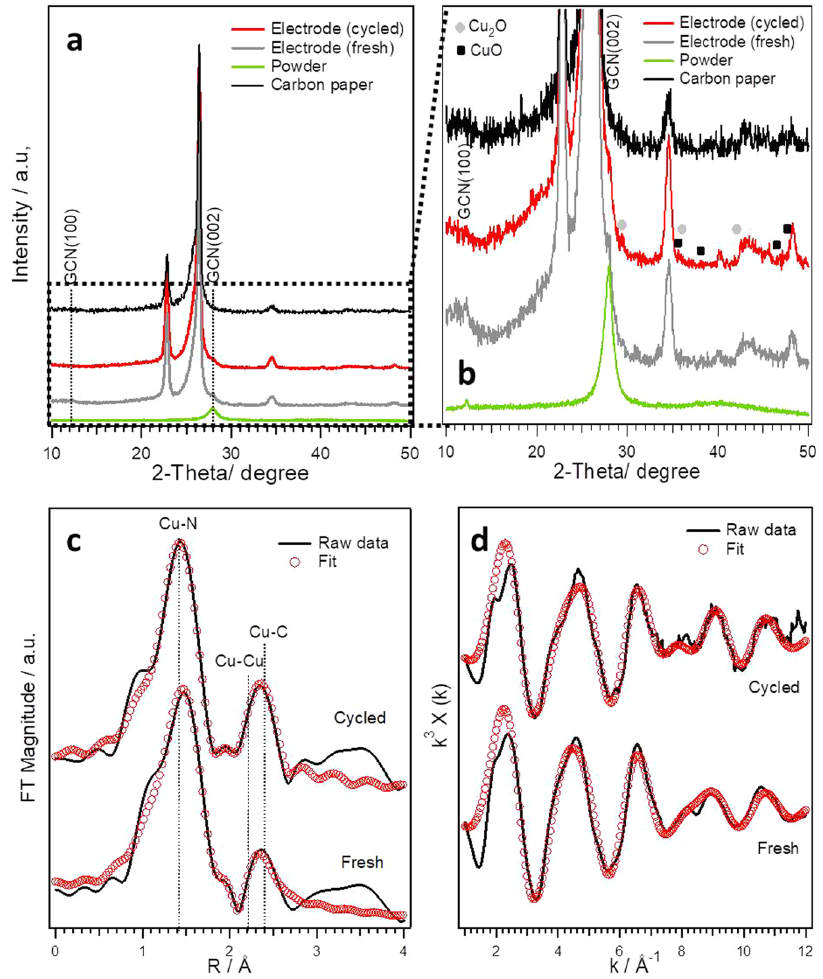
Fig. 7 Stability of Cu-GCN after reaction. a , b XRD patterns; c FT EXAFS, and d k 3 weighted experimental data (black) and corresponding fi ts (red) at the Cu K edge for the fresh and cycled